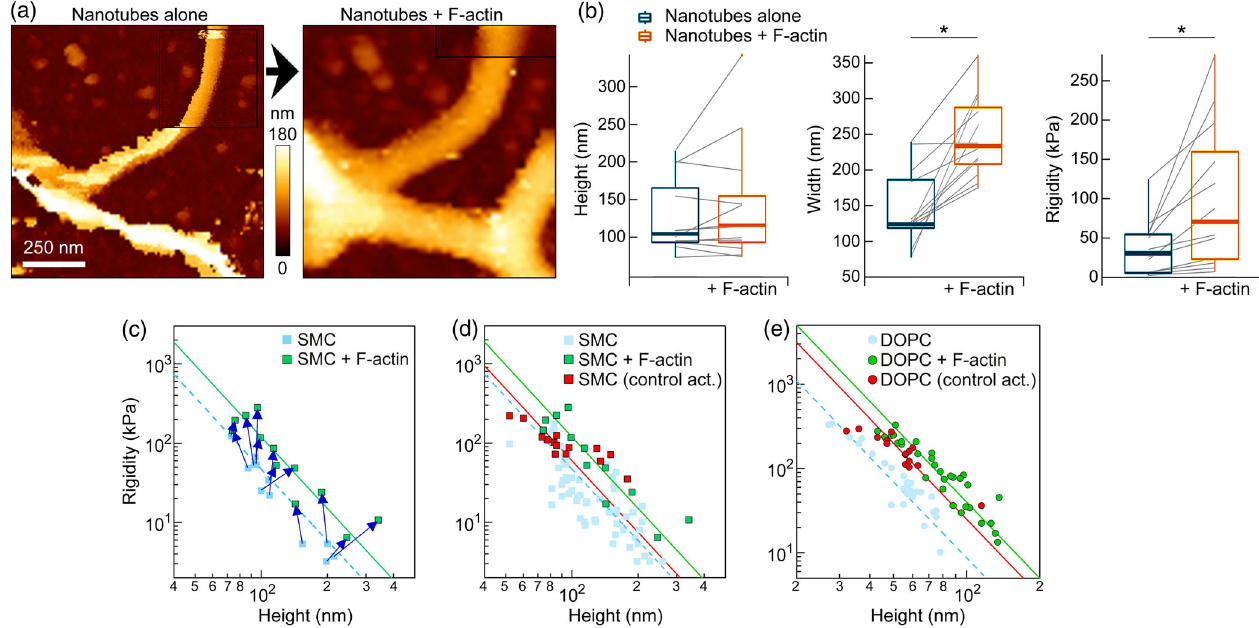
FIG. 7. Morphology and mechanics of nanotubes modified by actin. (a) AFM images of SMC nanotubes before (left) and after modification by actin and the activators of actin polymerization (right). Black rectangles delimit regions of the images scanned with a higher resolution. (b) From left to right: Heights, widths, and rigidities of the same SMC nanotubes before and after modification by actin (median and interquartile range; Wilcoxon match-paired test, (cid:4) p < 0 . 0005 ). Heights and widths were obtained from 0 and 2 pN height maps, respectively. (c) Rigidity versus height for the same SMC nanotubes, before and after modification by actin. The solid lines represent fits to the data of the relationship K ¼ χ h − 3 with χ an adjustable parameter. The dashed lines are given by Eq. (4) without any adjustable parameter. (d) Rigidity versus height for all the SMC nanotubes that we analyzed over multiple experiments, including a control dataset (control act.) in which only the activators of actin polymerization were incubated with the nanotubes (but not actin). (e) Rigidity versus height for all the DOPC nanotubes that we